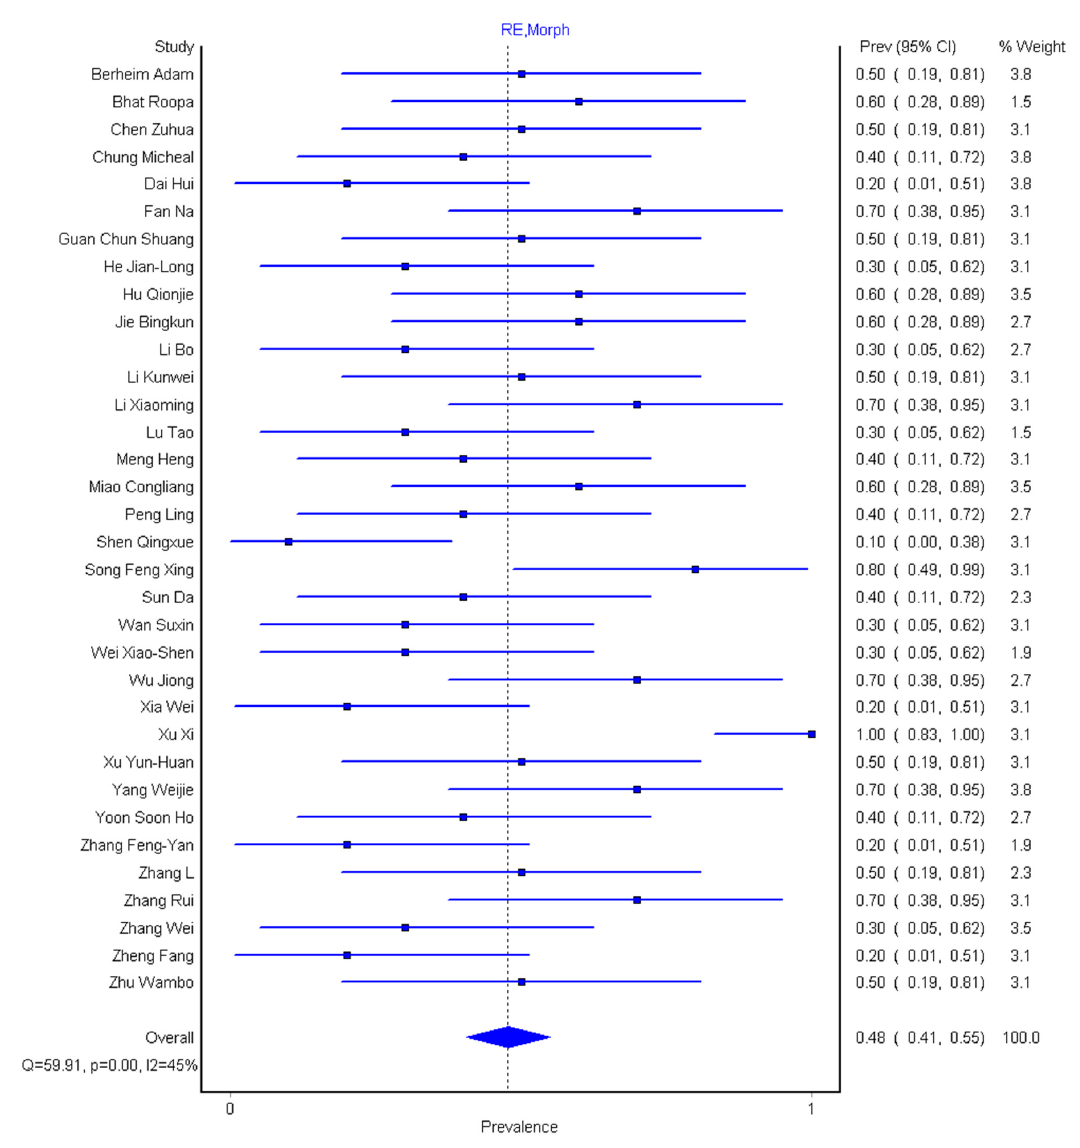
Figure 4. Forest plot of the pooled prevalence of morphological abnormalities among 34 patients.